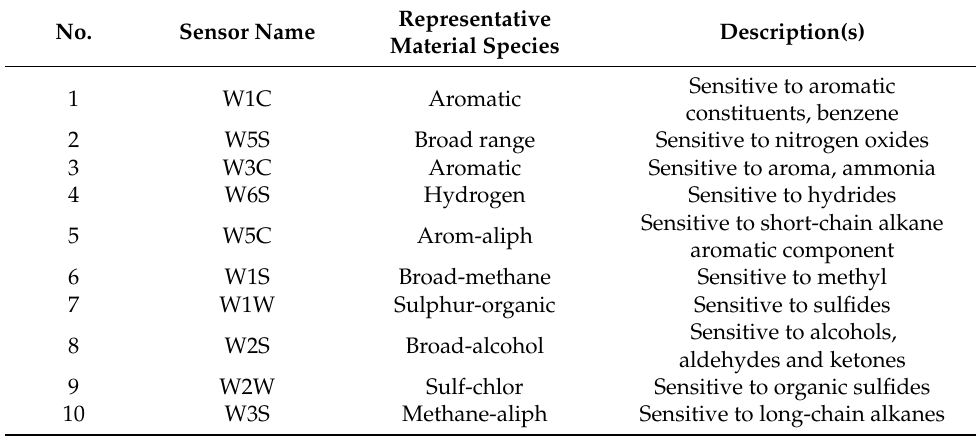
Table 1. Information of 10 sensors for electronic nose.